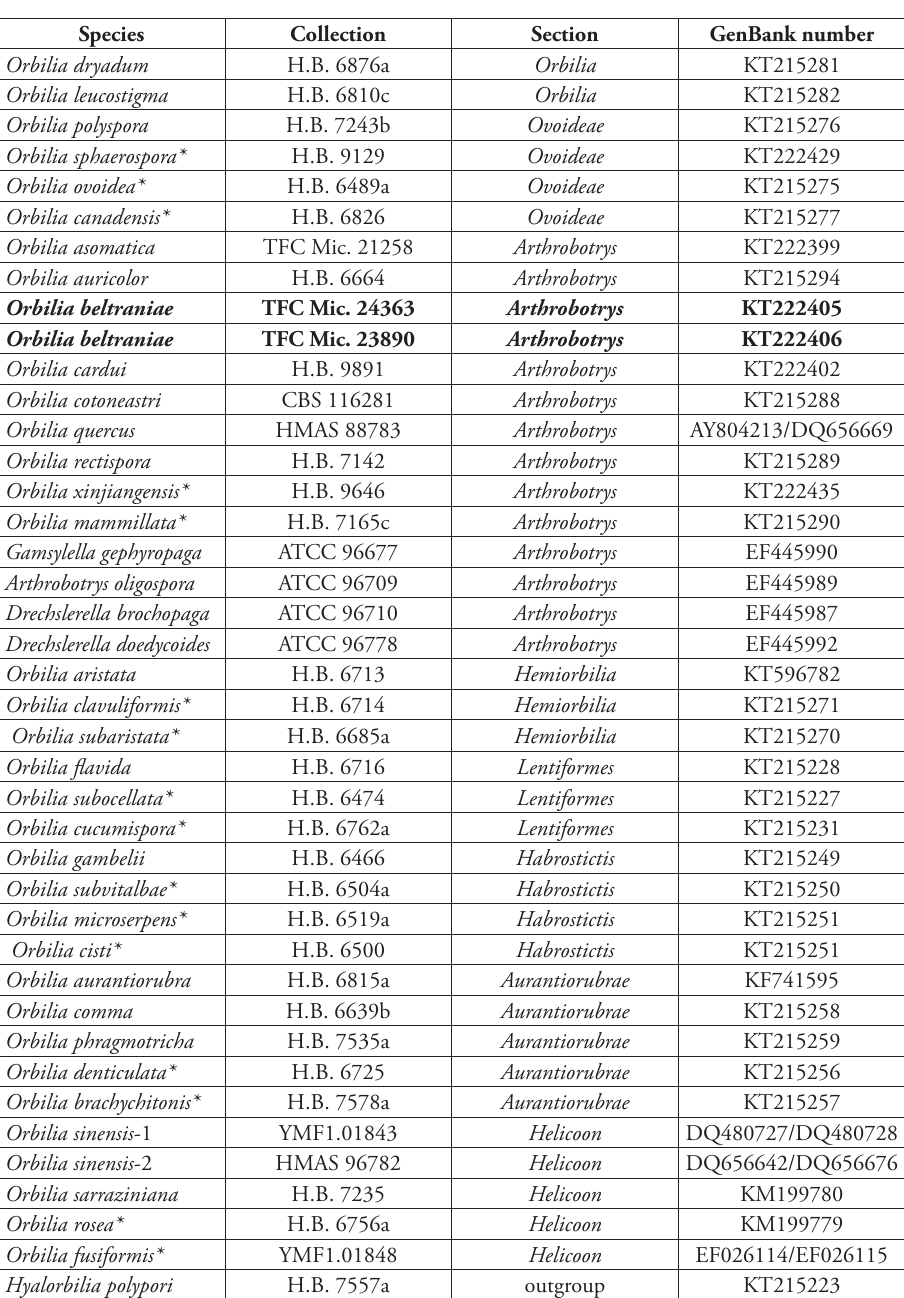
Table 1. Specimens used in this study with voucher information and GenBank accession numbers. Or- bilia beltraniae sequences are indicated in bold. Species with asterisk have at present unpublished names (Baral et al.